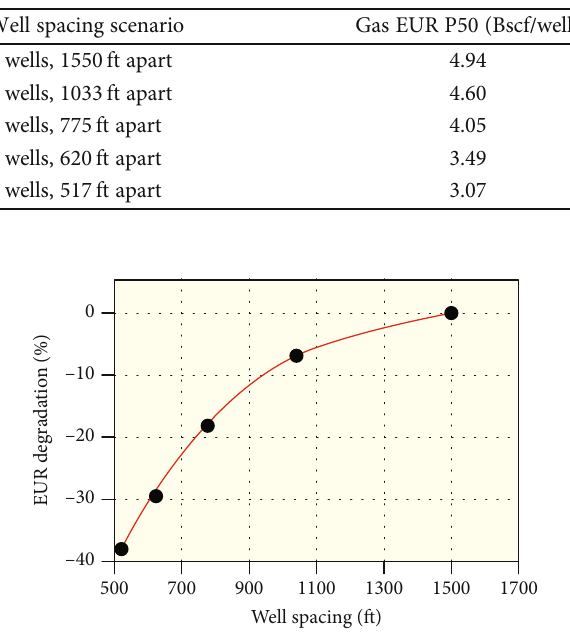
Table 3: P10, P50, and P90 of gas EUR of fi ve di ff erent well spacing scenarios.